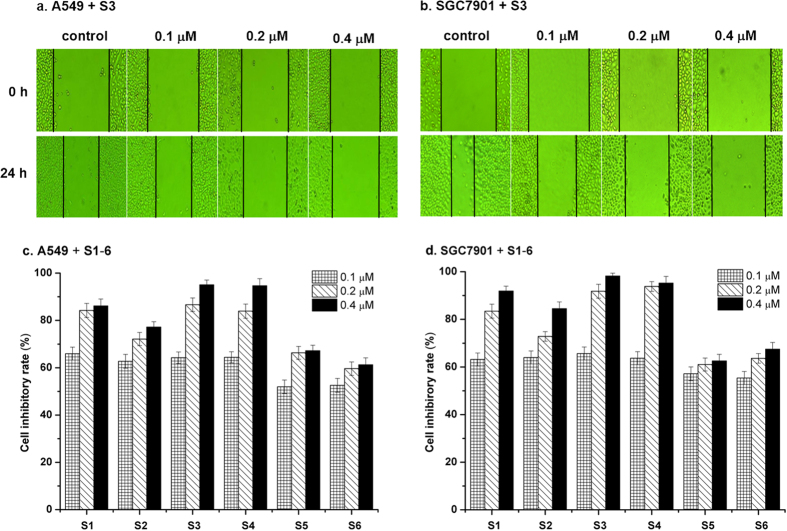
Effect of benzothioxanthene derivatives on the mobility of tumor cells.Cell wound healing assay was conducted in A549 (a) and SGC7901 (b) cells which were grown in culture dish and streaked with a pipet chip. After the addition of S3 to the culture at the indicated concentrations for 24 h, mobility of the cells was recorded under a microscope. In the bar charts, cell inhibitory rate (%) for suppression of the migration in A549 (c) cells and SGC7901 (d) cells as a function of concentrations of compounds S1–S6 showed mean results of three independent experiments in triplicates, where the width of the streaked line was measured at four to six reference points along the originally streaked line. The % cell inhibitory rate was calculated by the equation: cell inhibitory rate (%) = (1-Ddrug/Dcontrol) × 100%, where Ddrug is mean distance of cell migration in drug group, Dcontrol is mean distance of cell migration in control group; The % cell inhibitory rate for control is zero. Values are the means ± S.D. (P < 0.05). Other would healing assays are presented in Figure S7.